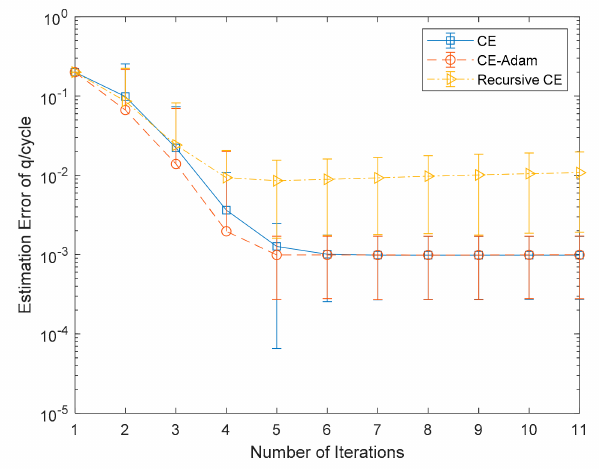
Figure 4. Monte Carlo simulation